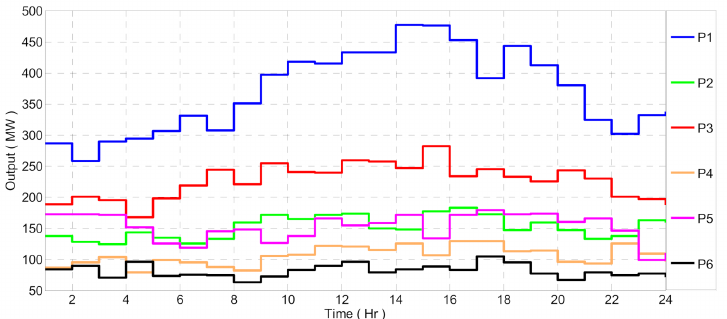
Figure 9. Optimal generation schedule under the scenario of Cost minimization (Test Case 1).